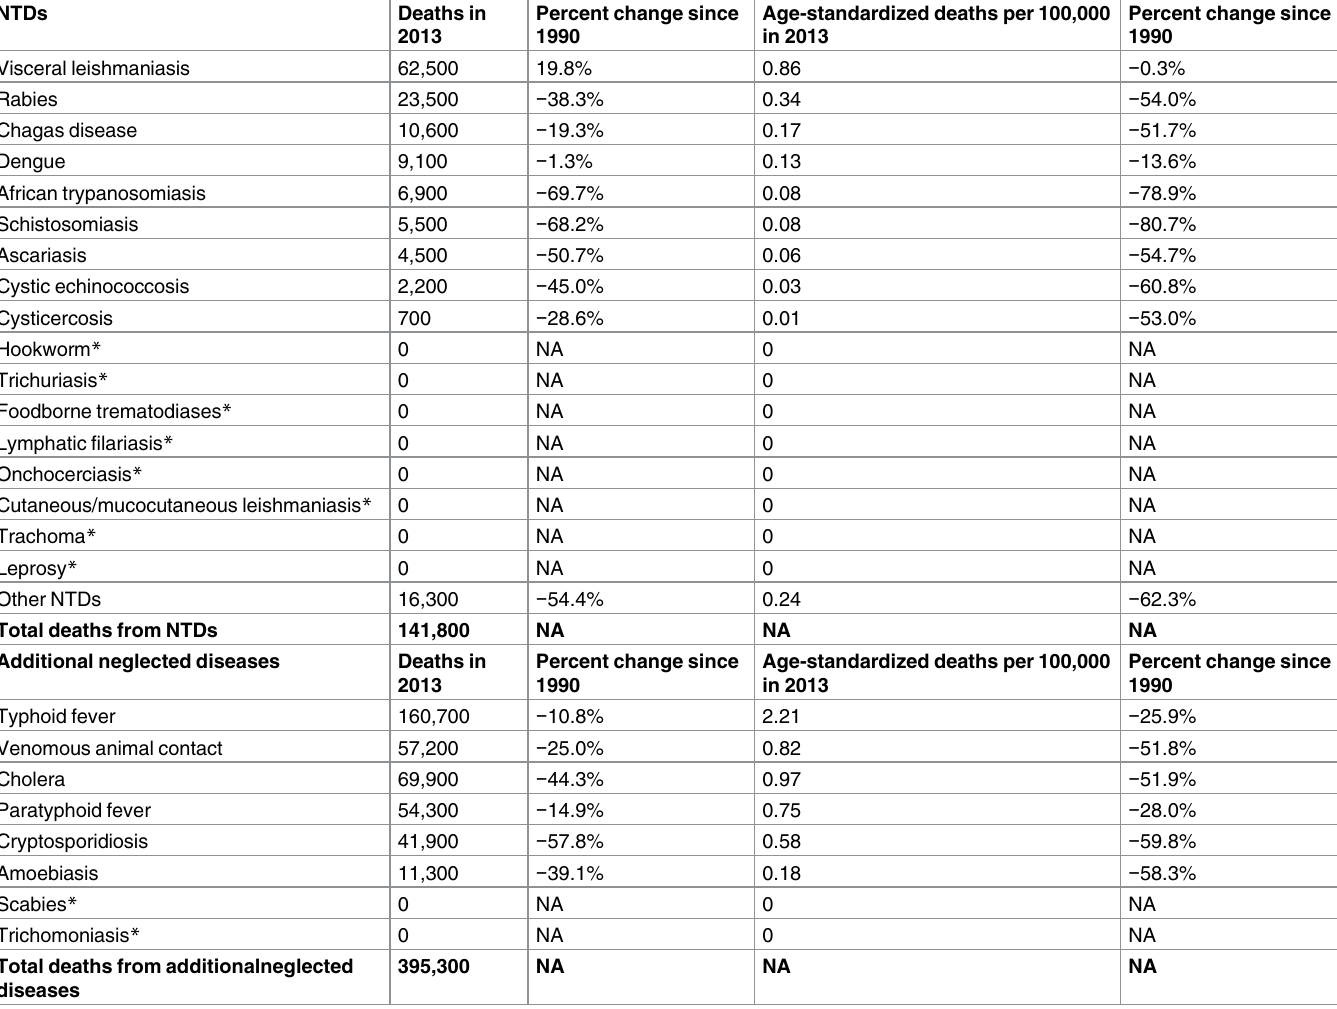
Table 2. Number of deaths and age-standardized death rates for NTDs in 2013 with percent change from 1990to 2013